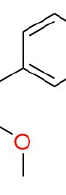
Figure 2. Chemical structure of karanjin (3-methoxy-2-phenylfuro[2,3-h]chromen-4-one).